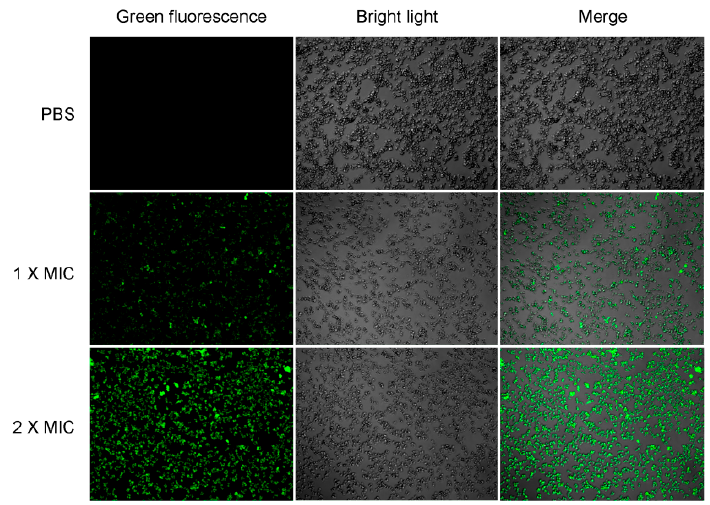
Figure 7. Binding of LHGH-1 to S. aureus . S. aureus was co-incultured with FITC-labeled LHGH-1 at PBS, 1 × MIC, 2 × MIC for 2 h and then examined by confocal laser scanning microscopy.